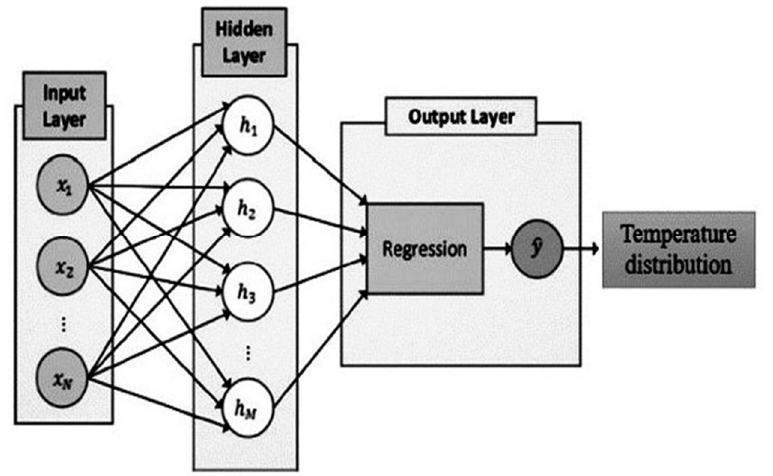
Figure 2. The DNN structure of a recent study.